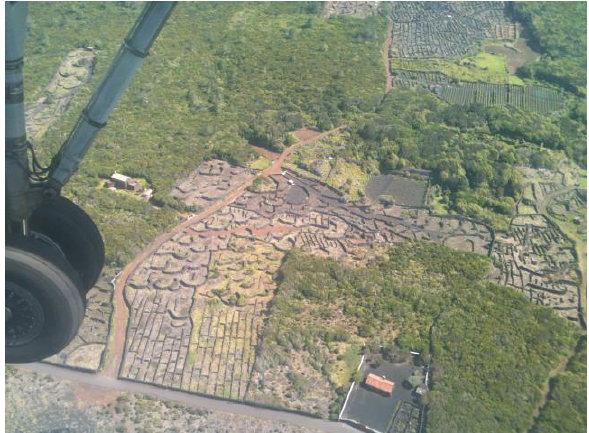
Figure 5. Aerial approach to Pico. Photo by Rui Florentino.